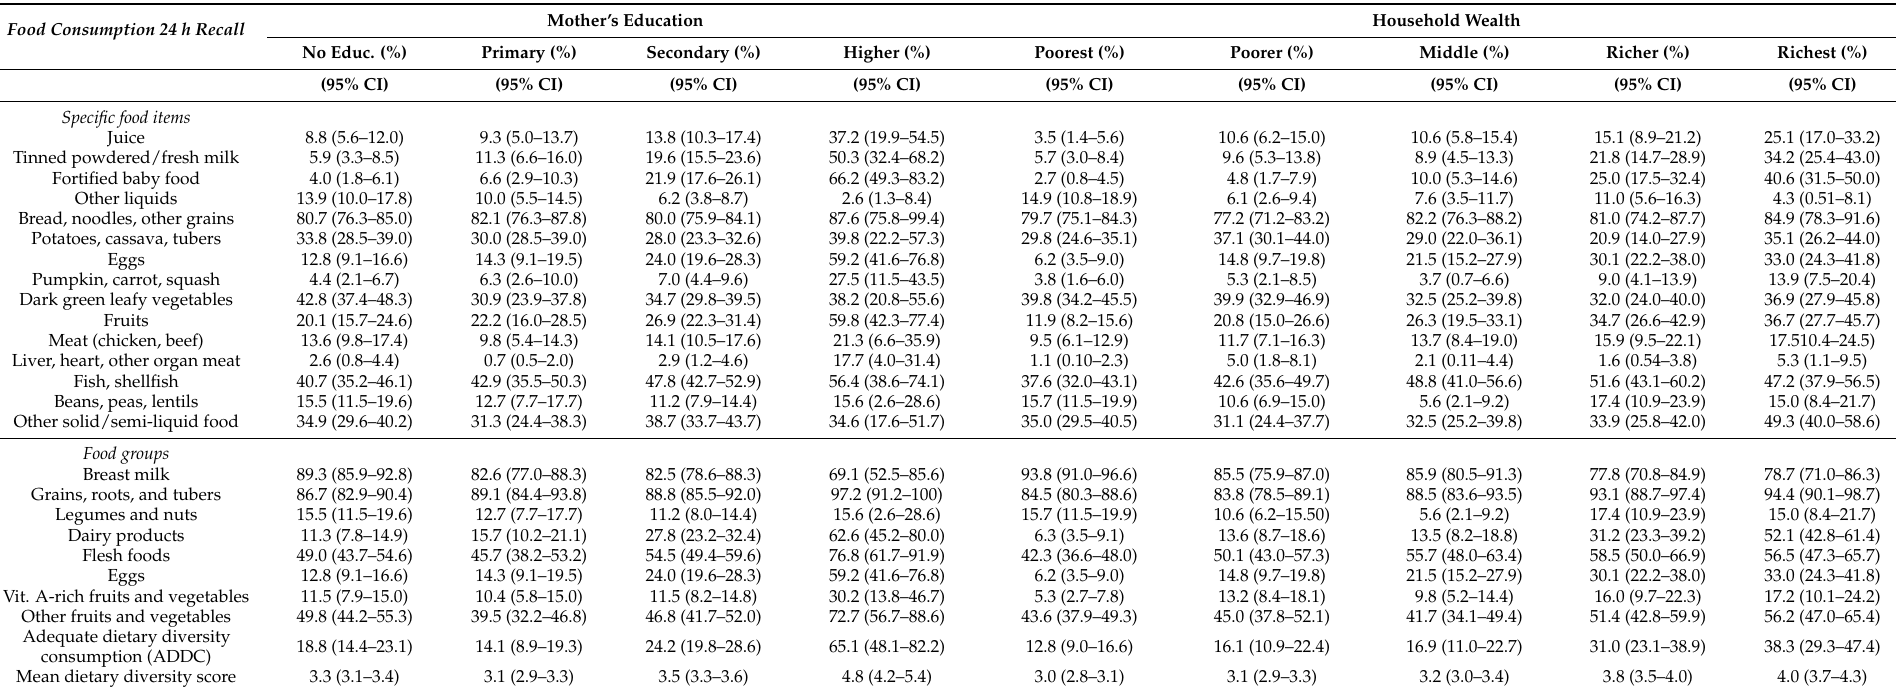
Table 4. 24 h recall of consumption of food items, food groups and dietary diversity by mother’s education and household wealth of children aged 6–23 months, mean values (%) with confidence intervals (CIs),